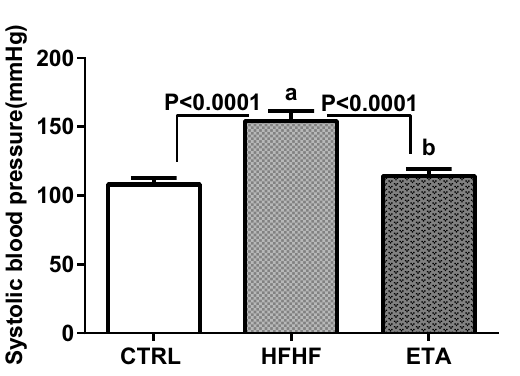
Figure 3. ETA attenuates HFHF-induced systolic blood pressure elevation. Data from the HFHF-fed rats and standard chow-fed rats (CTRL) are shown. Data are presented as the mean ± SD values and are representative of a single independent experiment ( n = 6). Statistical analysis was performed using one-way ANOVA, followed by Tukey’s multiple comparison tests. a Significantly different from the normal control group. b Significantly different from the HFHF group. Differences were considered significant if the p-value was < 0.05. CTRL control, ETA etanercept, HFHF high-fat high-fructose diet, SBP systolic blood